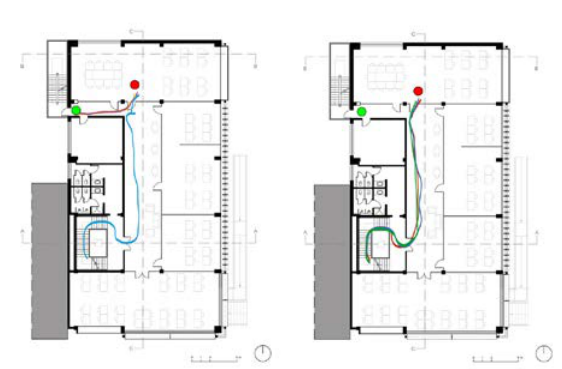
Figure 7: Path-finding for the Target 5 (emergency exit) in the actual building, left without signposting, right with signposting.